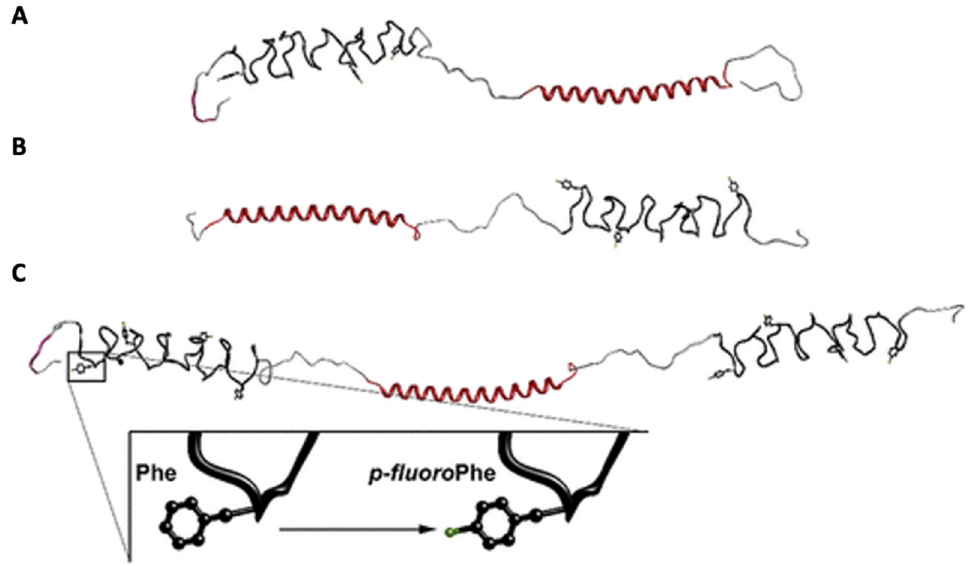
Figure 11. Three block copolymer proteins with residue-specific substitution of pFF. Elastin domains are colored in black and COMP domains are colored in red. Domains are linked by flanker regions containing repeats of AT. ( A ) pFF-EC. ( B ) pFF-CE. ( C ) pFF-ECE. Reprinted with permission from [60]. Copyright 2012 American Chemical Society.